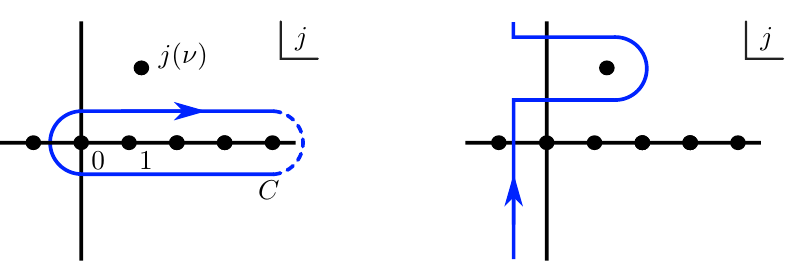
( z, z ) block. The ∆ ,J